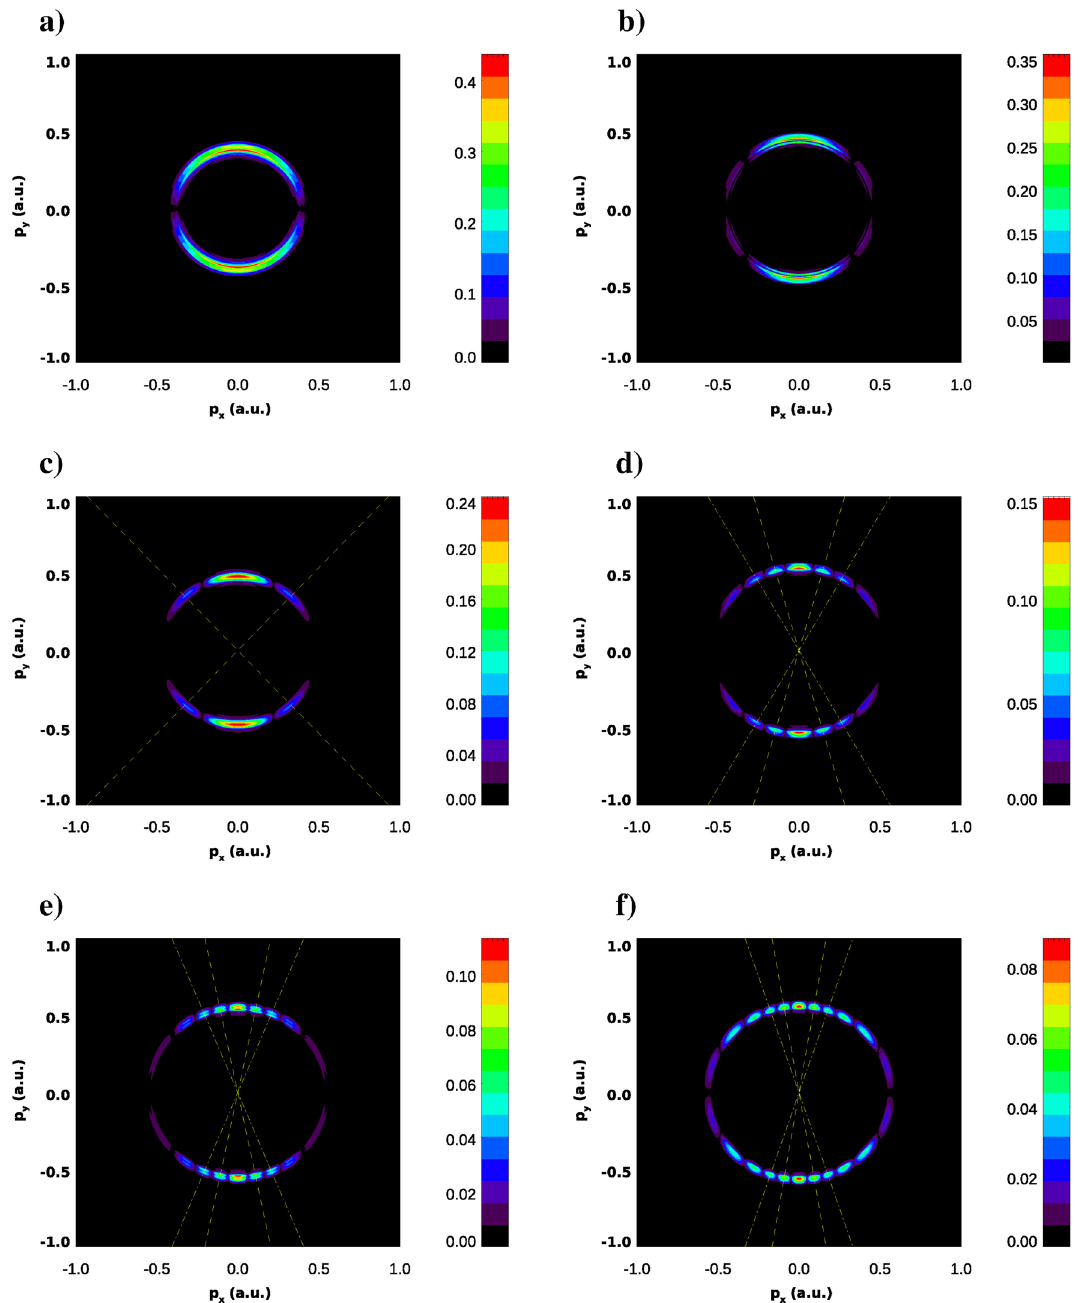
Figure 3. Photoelectron momentum distributions in the ( x , y ) plane for various IR field strengths and 0.2 a.u. PMD is exponentiated ( P ( p x , p y ) 1 / 3 is shown) for improving visibility frequency of the probe field (cid:31) = 0.02387 a.u. ( a ), E 0 of the patterns. IR field strengths are: E 0 = 0.125 a.u. ( e ), E 0 0.15 a.u. ( f ). Lines show directions to low order maxima of the interference a.u. ( d ), E 0 = =